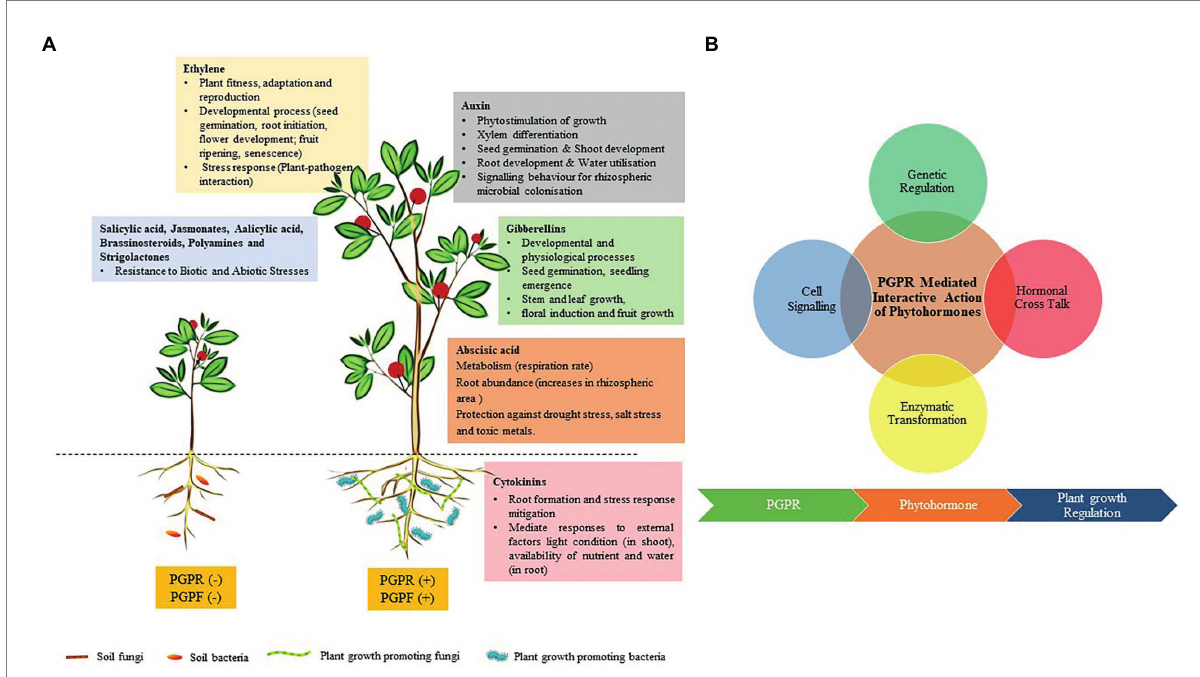
FIGURE 4 (A) Plant growth promotion through the production of different phytohormones and (B) PGPR-mediated plant growth promotion is governed through a complex network of cell signaling, genetic regulation, hormonal cross-talk, and enzymatic transformation. The PGPR generates multiple stimuli through the synthesis of phytohormones. These phytohormones interact through phosphorylation cascade or activating a secondary messenger which leads to the regulation of genes affecting hormone biosynthesis and developmental process in plants (Khan et al.,